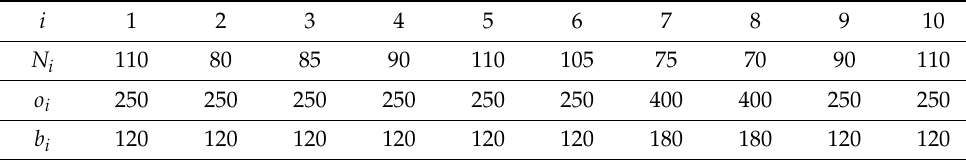
Table 8. Input values of constants N i , o i and b i for flights 1–10.